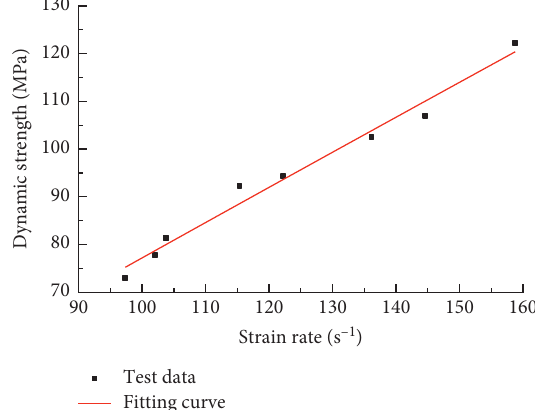
Figure 17: Relationship between dynamic strength and strain